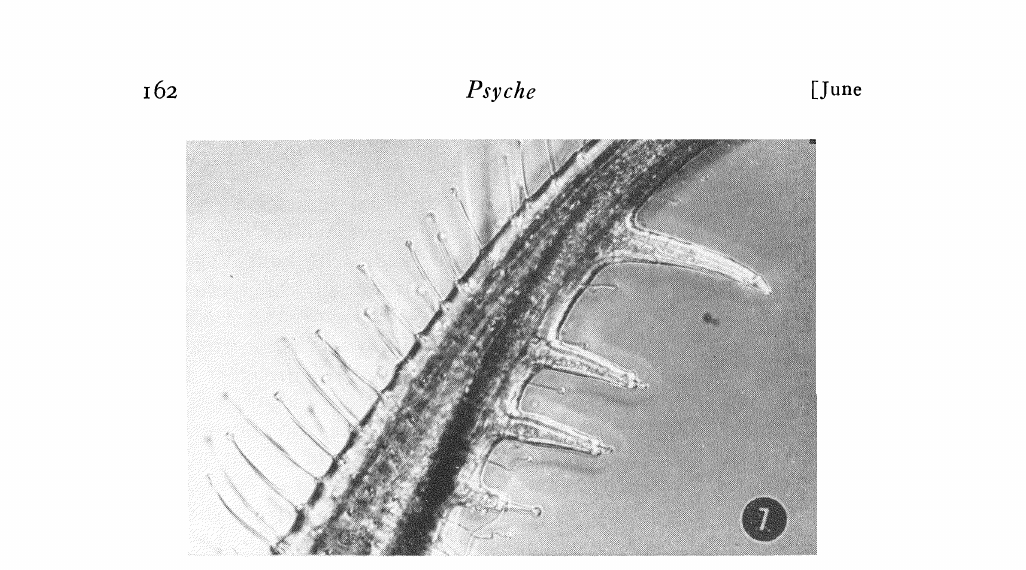
Fig. 7. Detail of left jaw of larva of ?Pronymphes mengeanus (Hagen) showing the small setae at the tips of the three proximal mandibular t.eeth and the globular tips of additional setae. Setae elsewhere on the body proper have these same modified tips. (Photographed with a Zeiss com- pound microscope using Nomarski interference contrast